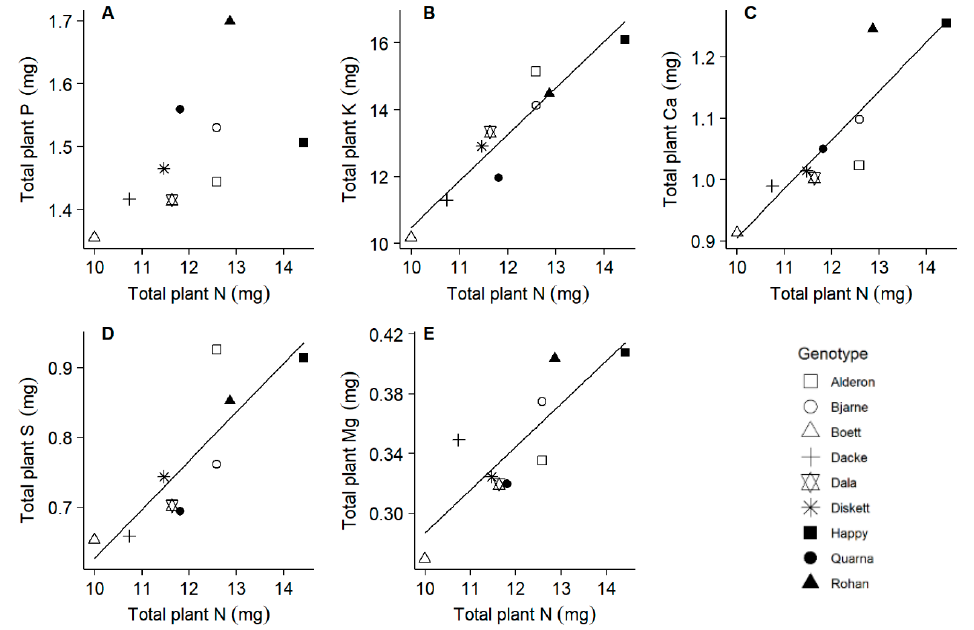
Figure 6. Relationships between the pools of various macronutrients in whole plants at day 20. Linear regressions: ( A ) r 2 = 0.241, p = 0.102; ( B ) r 2 = 0.876, p < 0.001; ( C ) r 2 = 0.761, p = 0.001; ( D ) r 2 = 0.697, p = 0.003; ( E ) r 2 = 0.662, p = 0.005.